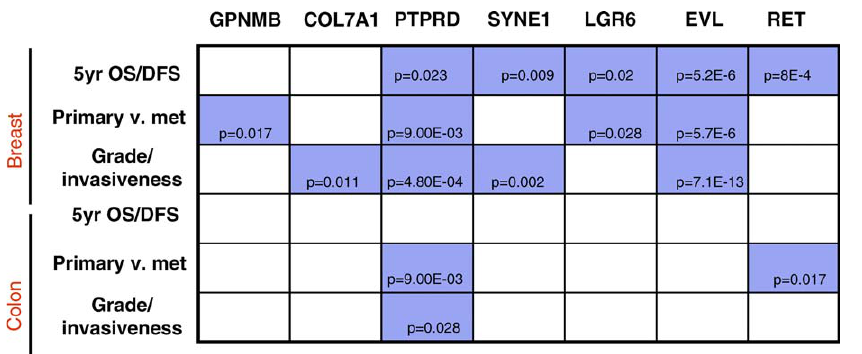
Figure 10. Decreased Expression of Hypermethylated ‘‘ Common Target ’’ Genes Predict for Poor Clinical Prognosis Summary of results from analysis of expression microarray data. p -Values from representative analyses for specific genes are shown. Blue indicates that a decrease in expression of the indicated gene is significantly associated with the following: overall survival or disease-specific survival less than 5 y, metastasis versus primary tumor, and/or increased grade or invasiveness. The p -value was calculated using the Student’s t -test with adjustment for multiple testing as described previously